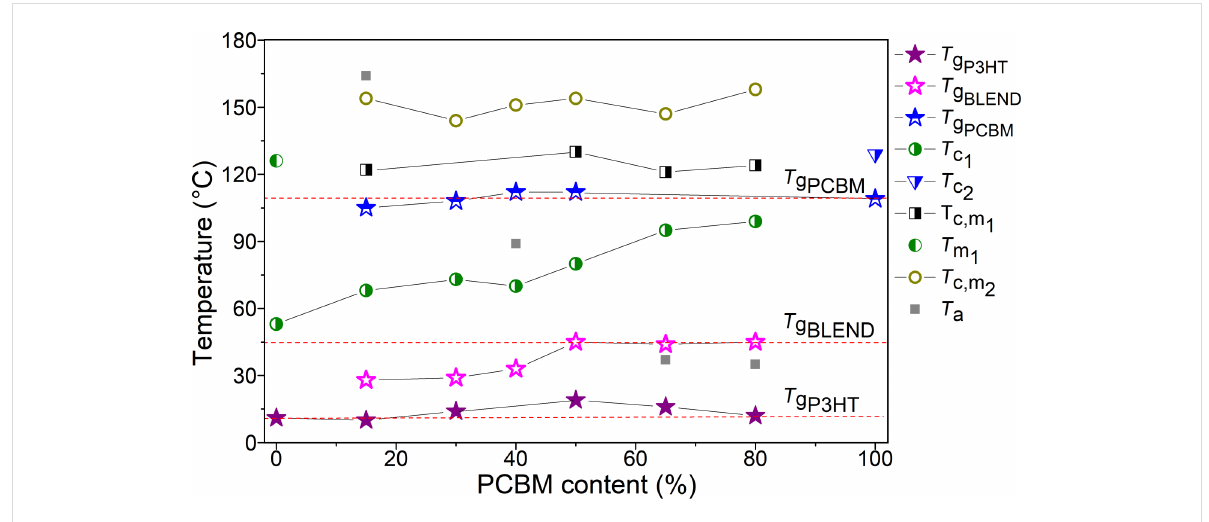
Figure 6: Phase diagram of P3HT:PCBM blends films. Symbols marked as T gP3HT , T gBLEND and T gPCBM denote the glass transitions of P3HT, P3HT:PCBM blend and PCBM phases. T c1 , T c2 , T c,m1 , T m1 and T c,m2 are phase transitions related the P3HT crystallization, the PCBM cold crystalli- zation, the melting of P3HT crystallization and/or crystallization of PCBM, melting of P3HT crystallization as well as the additional crystallization of PCBM, respectively. Symbols marked as T a denote additional phase transitions.